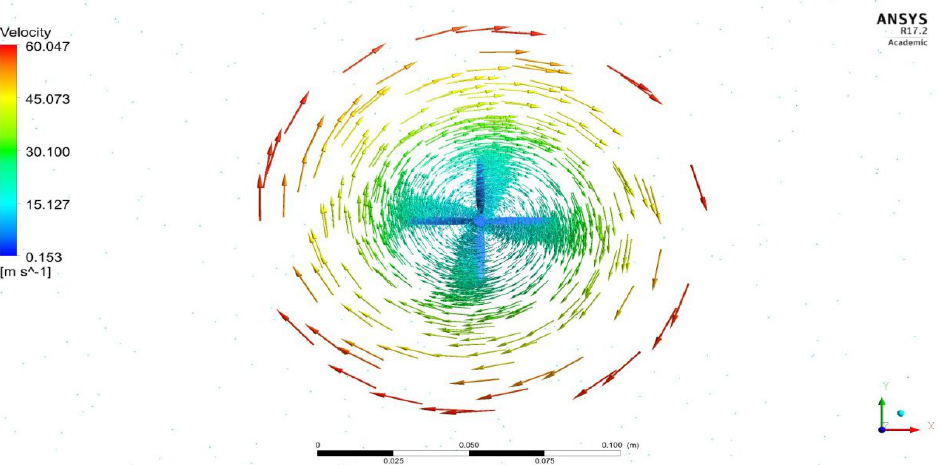
Figure 53. Hydrodynamic velocity variations on the UAV propeller under 8000 RPM with wave celerity of 12.10 m/s.